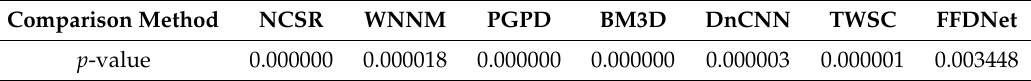
Table 8. Multiple comparisons for Two-Way ANOVA of the average PSNRs (dB) of the commonly used test